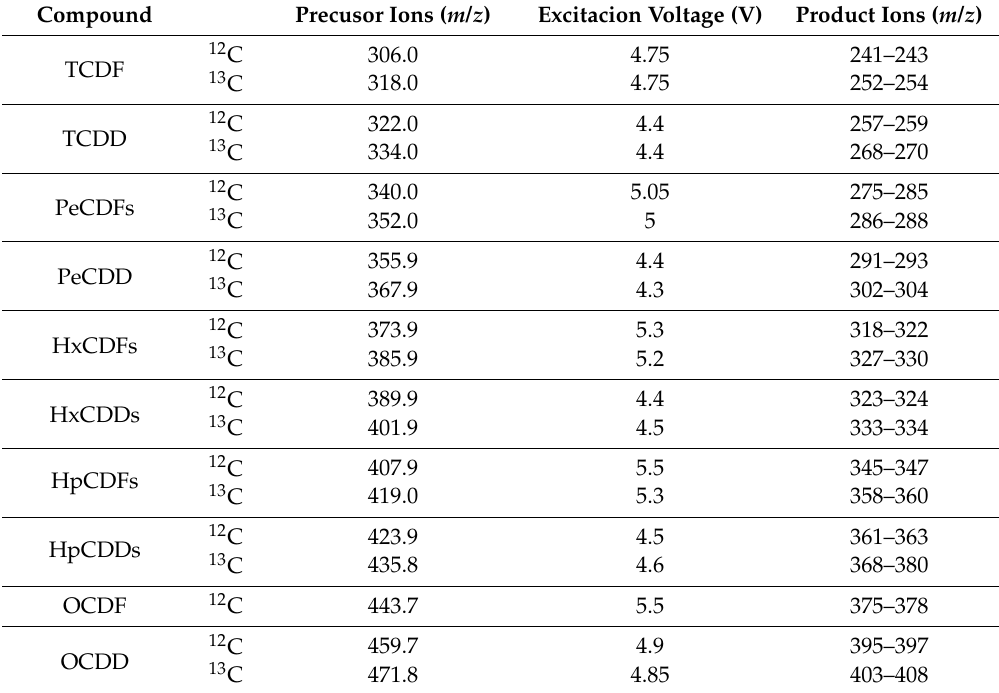
Table 2. The optimized tandem mass spectrometry (MS/MS) parameters for The analysis of polychlorinated dibenzo-furans (PCDD/Fs) in gas chromatography mass spectrometry (GC/MS) PolarisQ used in MS/MS